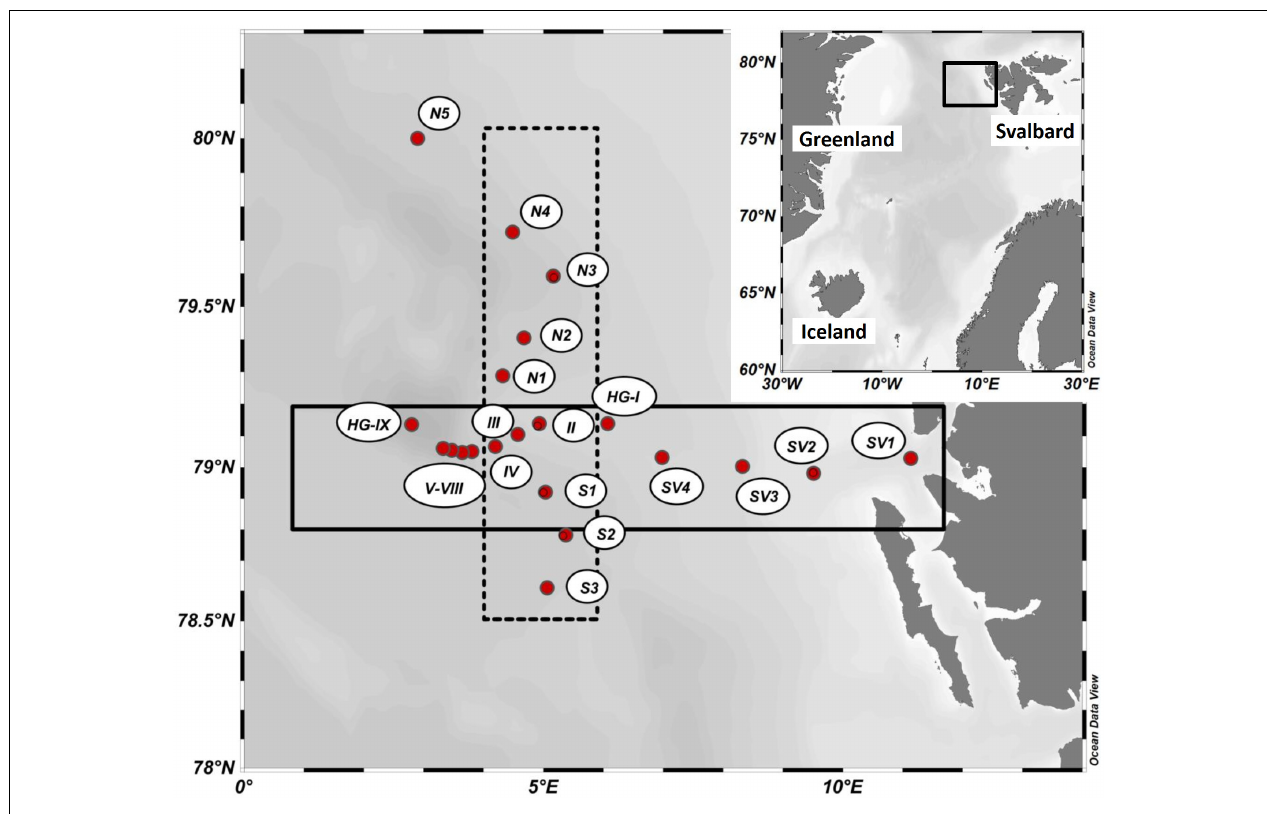
FIGURE 1 | Map of the LTER HAUSGARTEN and typical stations visited during the summer season in 8 years between 2009 and 2017.